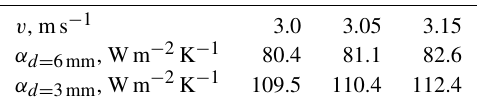
Figure 6. Flow velocity in the area of the point of installation. Table 1. Dependency of the flow velocity on the heat transfer coef- ficient ( α calculated by using VDI, 2013).